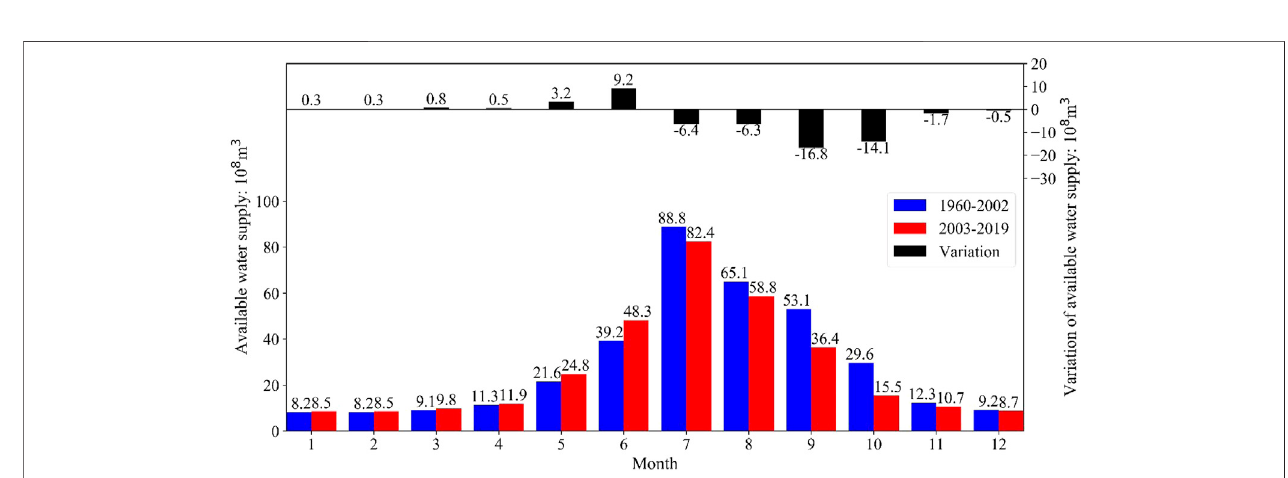
FIGURE 7 | Multiyear average available water supply and monthly variations before and after the operation of the Three Gorges Reservoir.